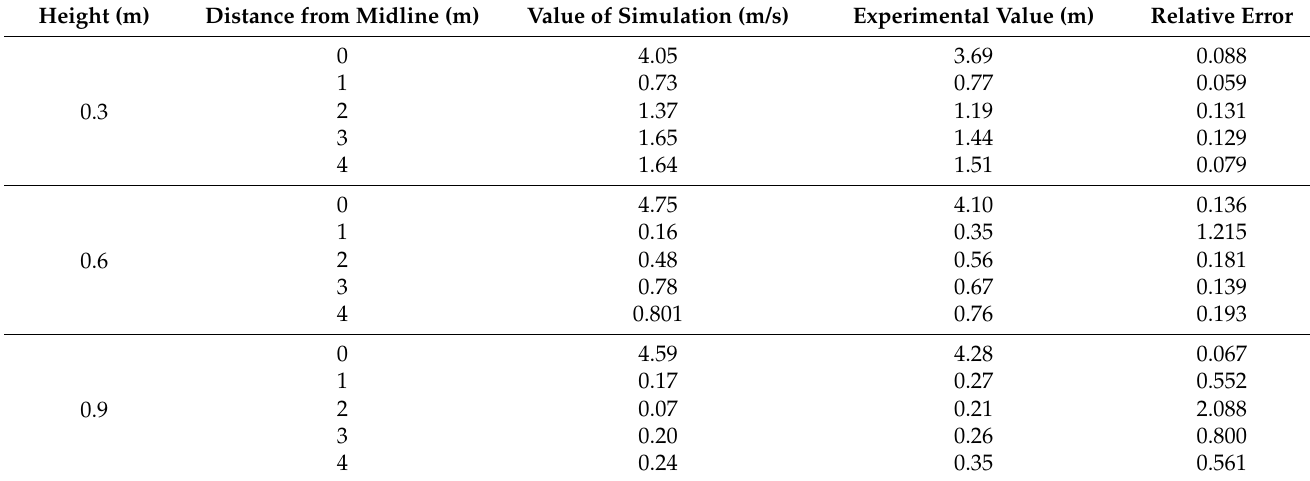
Figure 12. Greenhouse test. ( a ) Anemometer and UAV; ( b ) UAV flight in greenhouse. Table 5. Comparison between measured and simulated values. Table 5. Comparison between measured and simulated values.